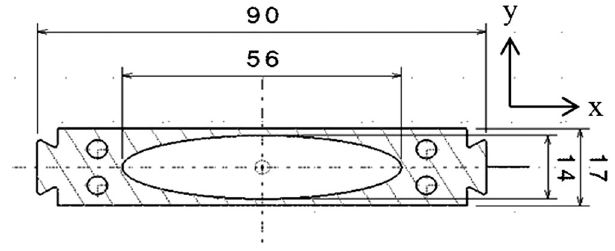
FIG. 1. Typical cross section of vacuum chambers in straight sections. Dimensions are given in mm and correspond to the case in the long